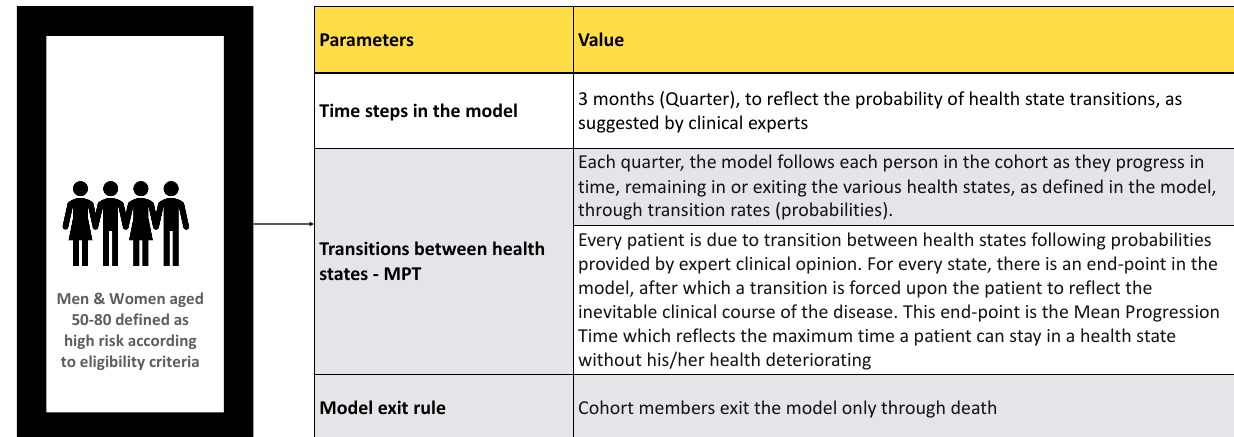
Figure 2. Design of the hypothetical model inputs.